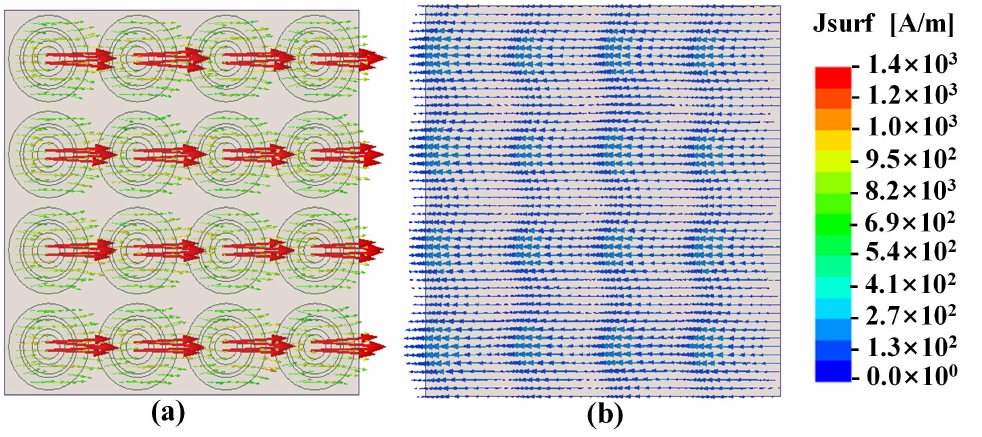
Figure 7. The simulated surface current density of ( a ) the second graphene layer and ( b ) the backed ground at the frequency of f 2 = 6